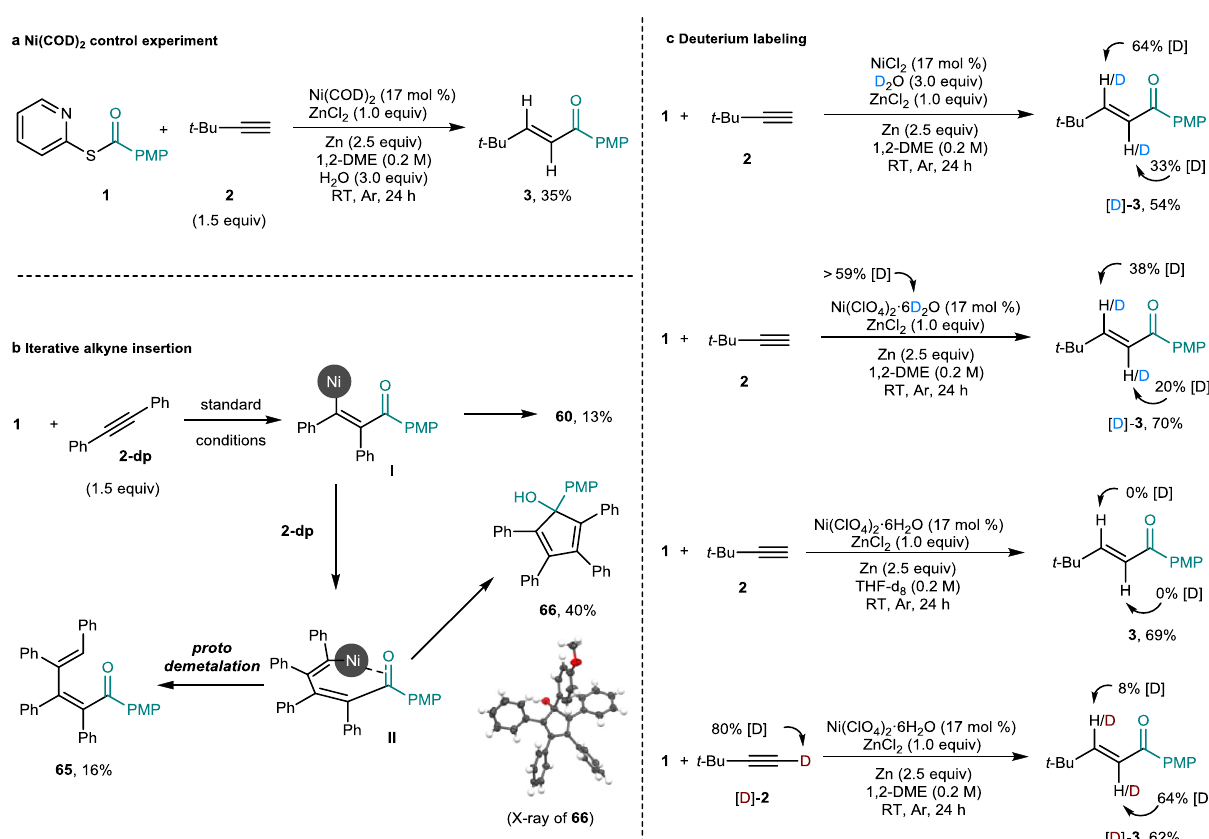
Fig. 3 Mechanistic and deuterium labeling studies. a Ni(COD) 2 control experiment. b Iterative alkyne insertion. c Deuterium labeling.